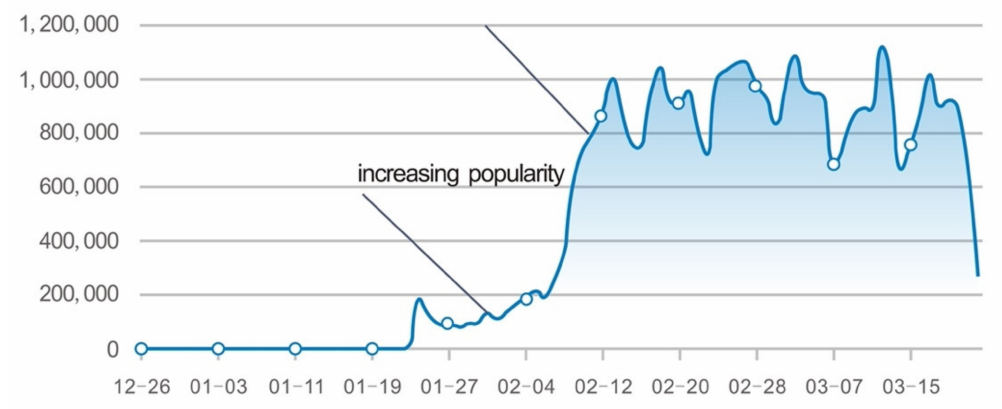
Figure 3. Increase in popularity of name No. 5 X¯ıngu¯an f è iy á n between the end of January and middle of February